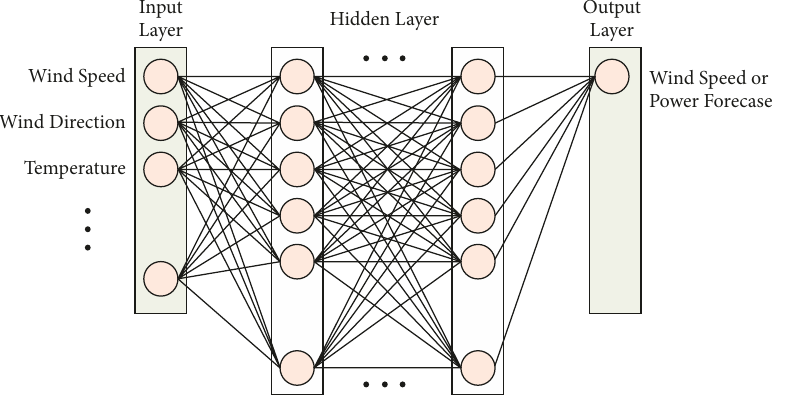
Figure 2: The common topology of a BPNN